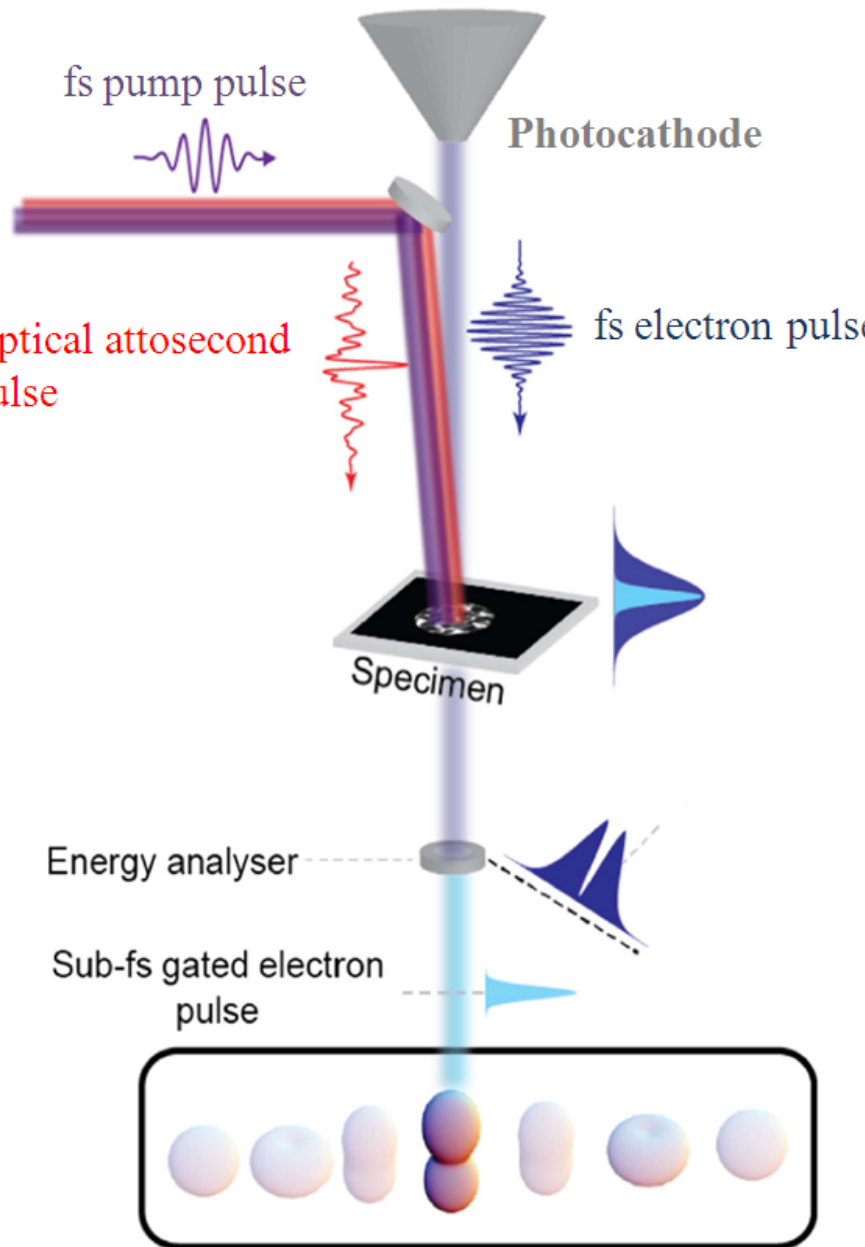
Figure 6. Illustration explaining the conceptual scheme of attosecond electron microscopy. Here, an optical attosecond pulse serves as an instantaneous gate to form an isolated ultrashort electron burst, which should be filtered after gating. As a result, the prepared attosecond free electron pulses can be used to detect ultrafast laser-induced electron dynamics in real-time (adapted from work in [54] with minor changes).